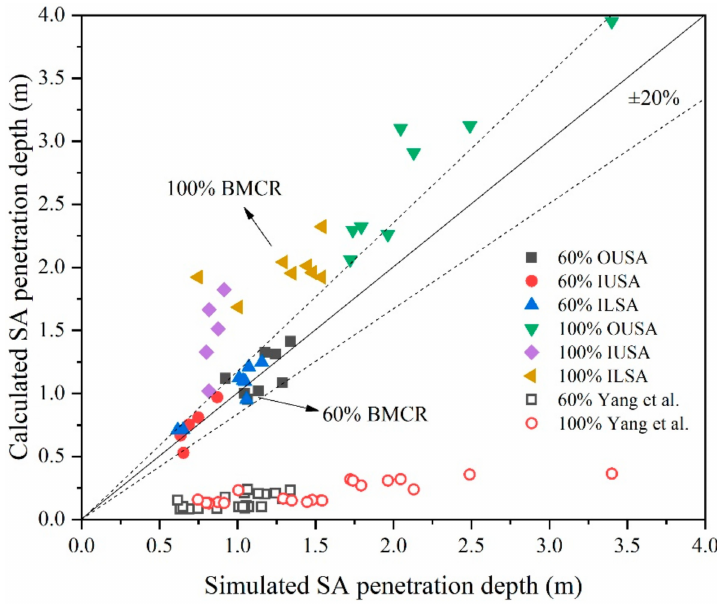
Figure 15. Prediction of SA penetration depth under 60% and 100% BMCR loads with actual SA velocity